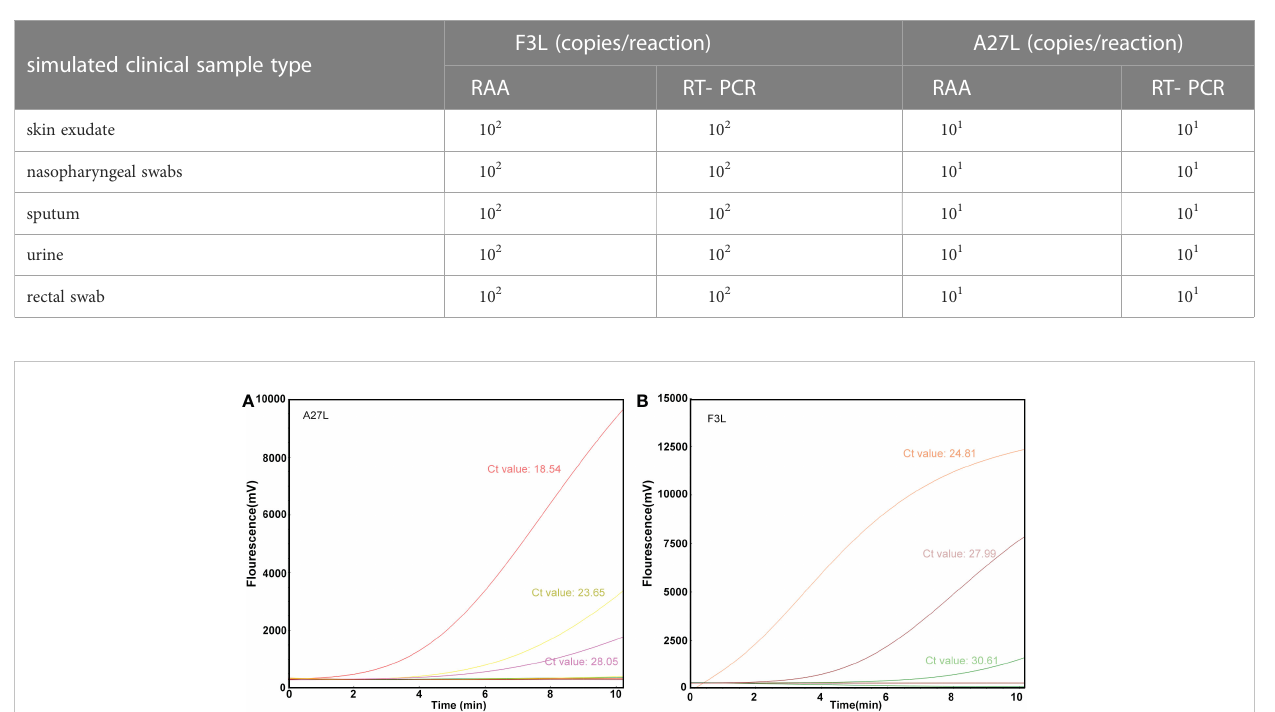
TABLE 2 Lower limits of detection in different kinds of simulated clinical samples.